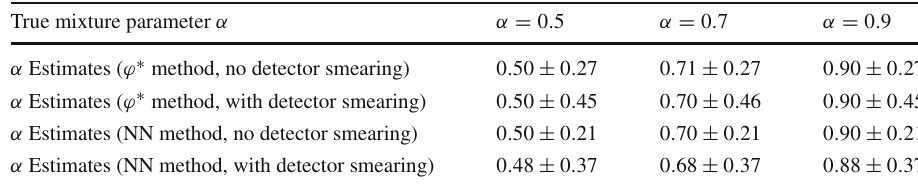
Fig. 4 Comparison of the distributions of α estimates using a the ϕ ∗ method and b the neural network method, for test sets generated with α = 0 . 5 (top), α = 0 . 7 (middle) and α = 0 . 9 (bottom). The slight deviation from Gaussianity seen around ˆ α = 1 . 2 in the bottom right plot is due to the fact that we let α vary beyond [ 0 , 1 ] in our fits, but still demand that that the mixture model p ( y | α) is always non-negative. See the text for further details